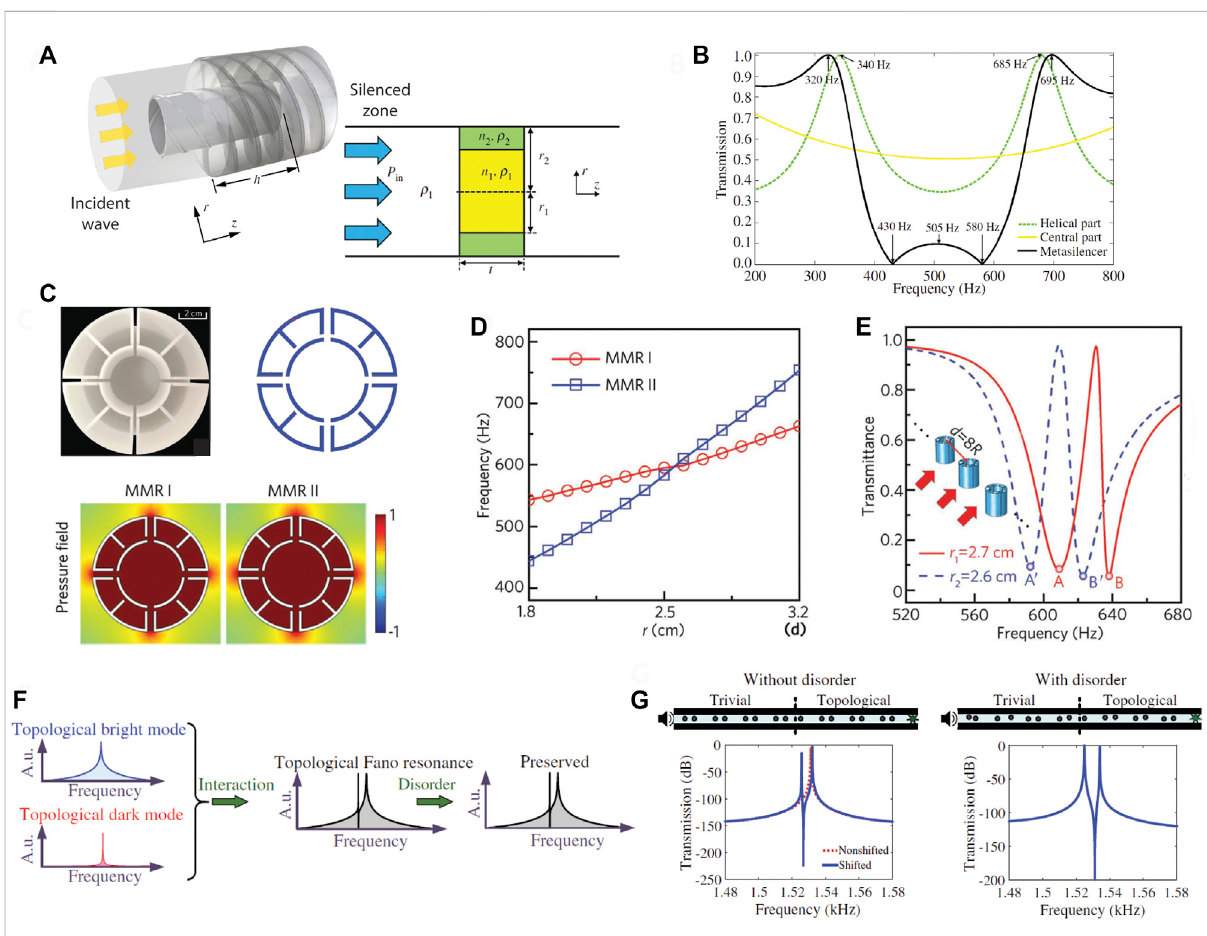
FIGURE 11 Fano resonance in coupled resonators. (A) Fano resonance-based Duct silencer. (B) Transmission spectra of each contribution. (C) Dual Fano resonance by Mie resonators supporting two-type monopole resonances (D) and (E) corresponding transmission spectra. (F) Topological Fano resonance. (G) Robust Fano resonance with and without disorder. Reprint (A,B) from Ref. [61]; (C – E) from Ref. [62]; (F,G) from Ref.